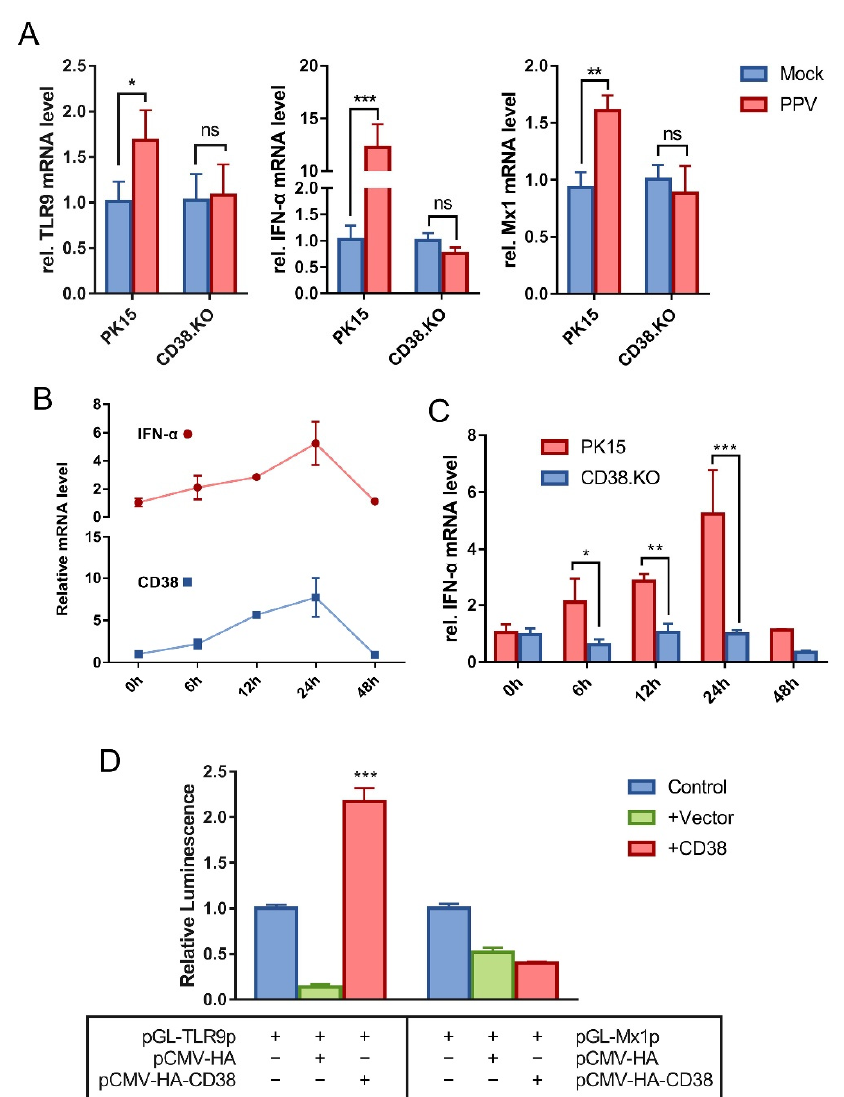
Figure 2. CD38 participates in the TLR9/IFN- α /Mx1 pathway activated by PPV. Quantitative real- time RT-PCR was used to detect the relative transcription level of cytokines in PPV-infected cells (MOI = 1), with β -actin as the internal reference gene. ( A ) The relative mRNA levels of TLR9, IFN- α , and Mx1 in CD38.KO cells (24 hpi), PK-15 cells as control. ( B ) The relative IFN- α and CD38 mRNA levels in PK-15 cells (0–48 hpi). ( C ) The mRNA level of relative IFN- α in CD38.KO cells (0–48 hpi), PK-15 cells as control. ( D ) The reporter plasmid containing promoter and the target plasmid were transfected into HEK-293T cells. The luminescence of Renilla luciferase detected is shown as fold change by normalizing to the sample-transfected-only reporter plasmid. *: p < 0.05, **: p < 0.01, ***: p < 0.001, and ns: not